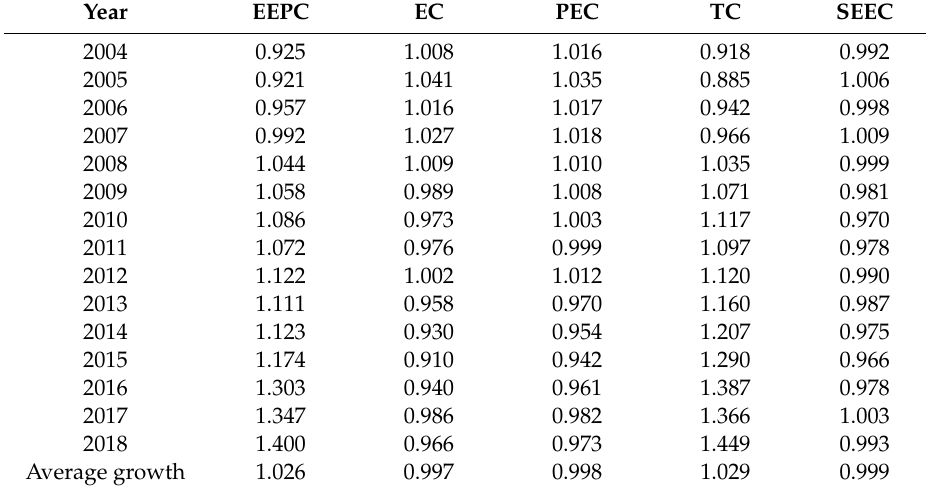
Table 3. Cumulative value of EEPC and its decomposition of overall resource-based cities from 2003 to